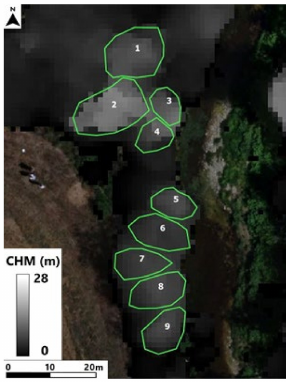
Figure 5. Orthomosaic and canopy height model (CHM) (with transparency for values = 0) used for on-screen interpretation to extract trees’